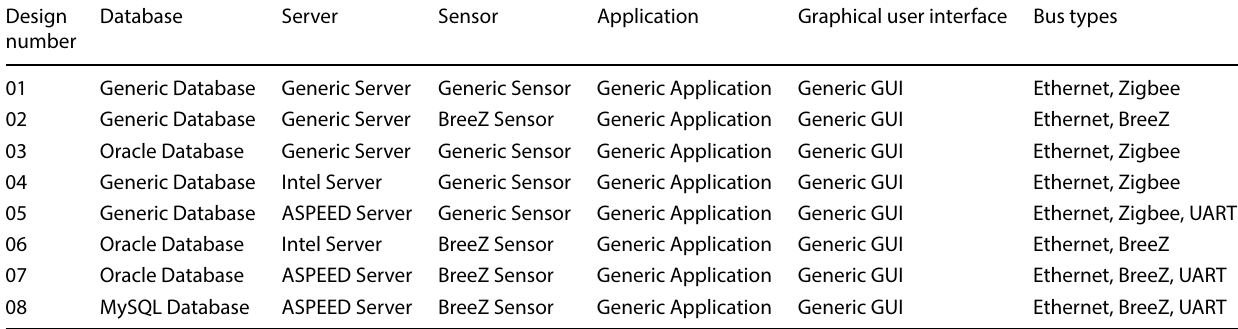
Table 2 Table of IoT Home Model Variations and